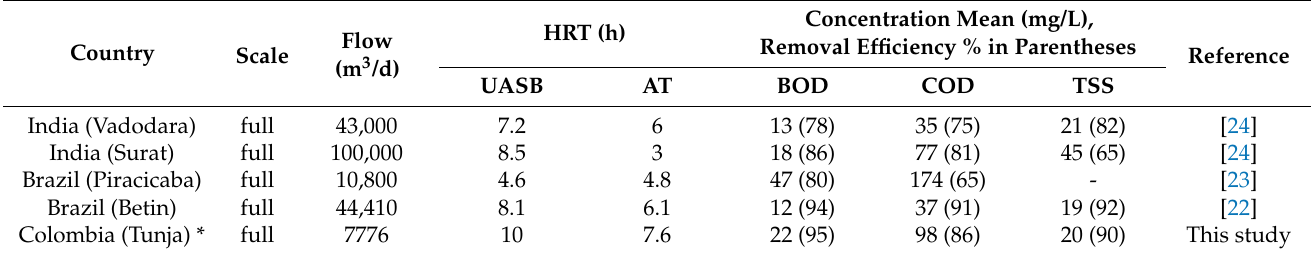
Table 6. Full-scale experiences with UASB-AS systems treating